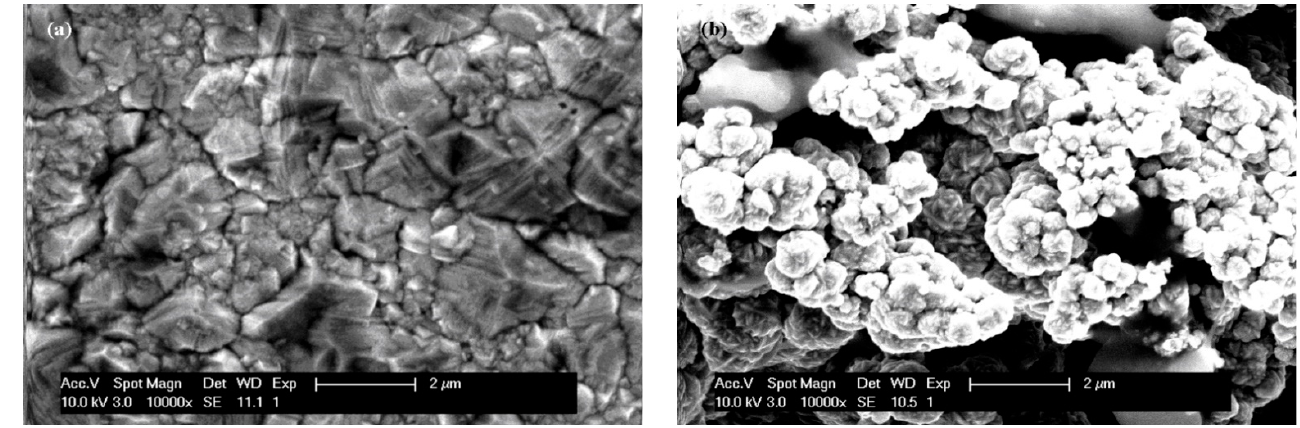
Figure 1. SEM surface micrographs of: ( a ) pure Ni layer; ( b ) Ni/nano-TiC composite layer.